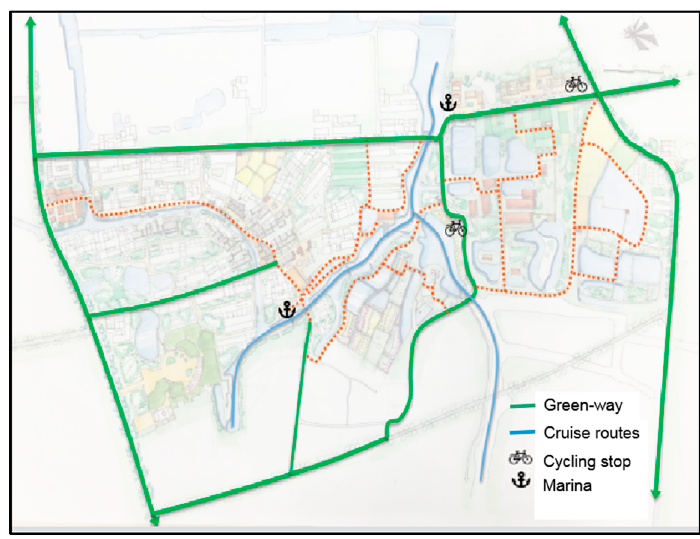
Figure 6. Plans of green-way and blue-way systems in Pu’an village.